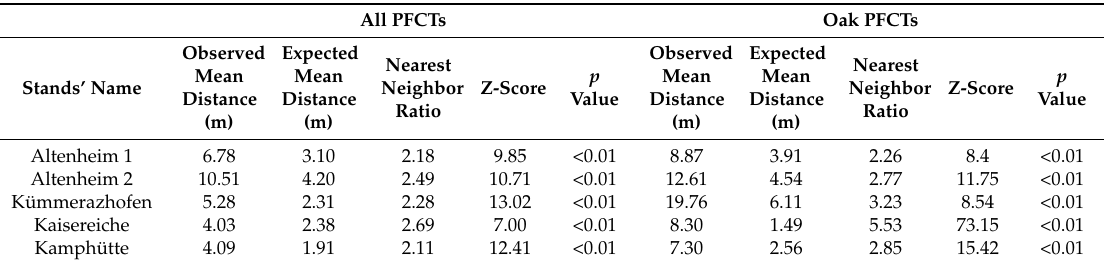
Table 6. Results of the Nearest Neighbor Analysis on the distribution of PFCTs in individual group planting stands (m =